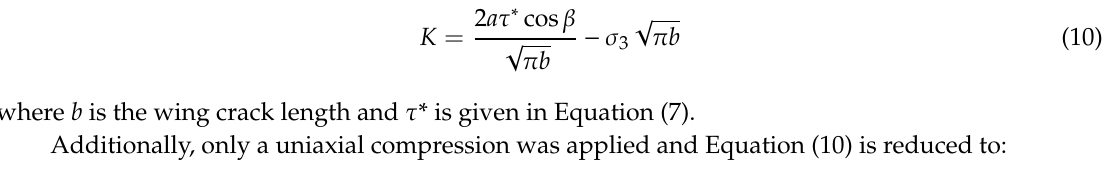
Figure 13. Schematic illustration of the crack model ( a ) shear crack mode; ( b ) sliding crack model.